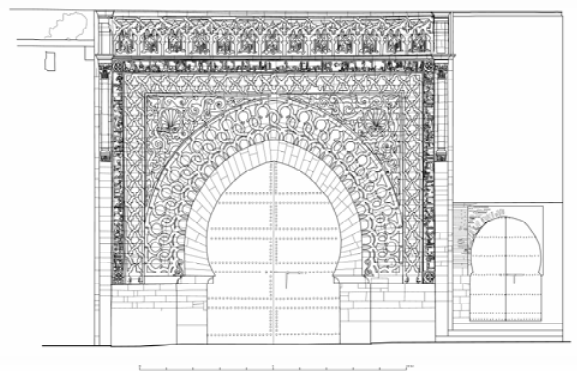
Figure 5. Elevation of the interior gate of Bab al-Kebir in